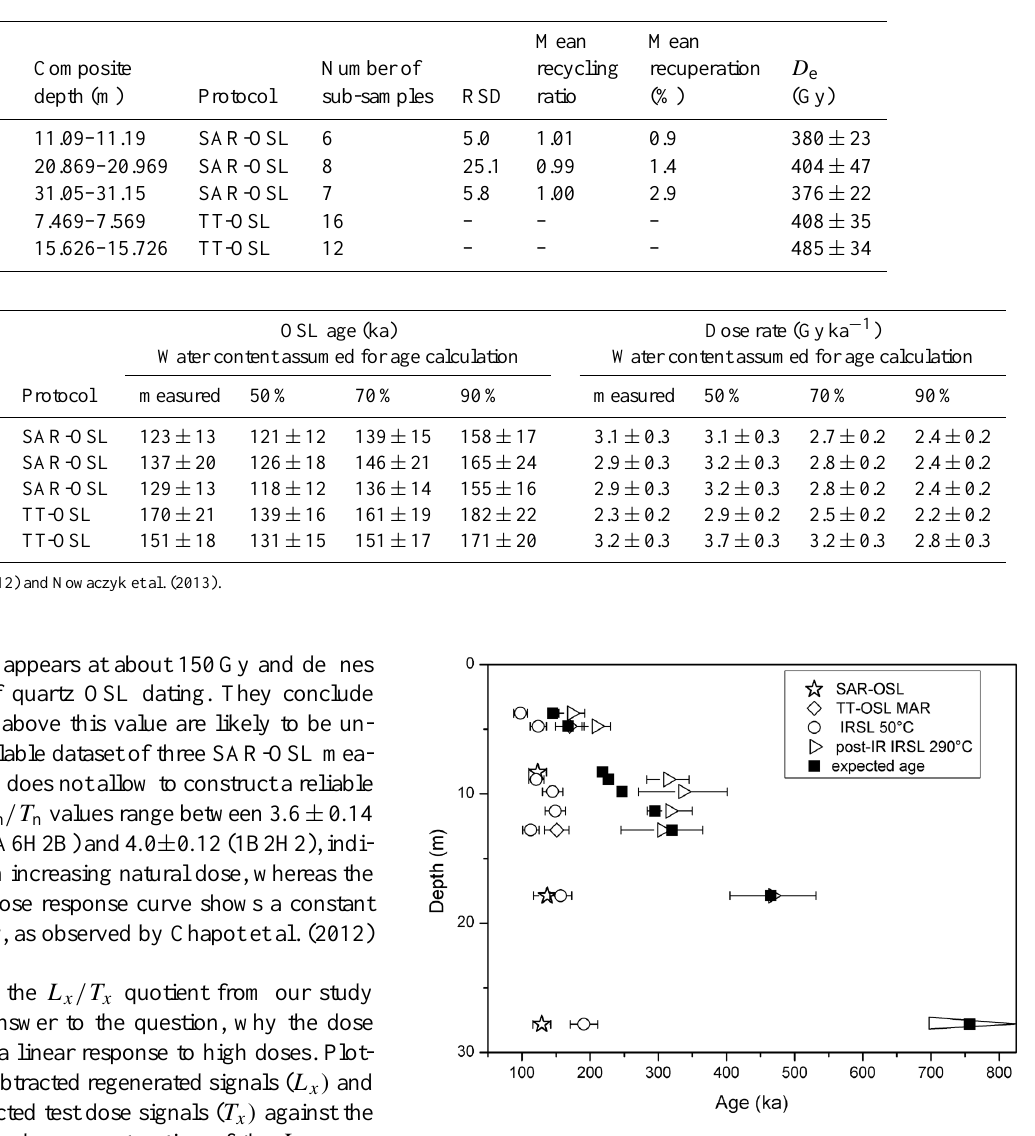
Fig. 6. Comparison of the expected ages from an independent age model (Melles et al., 2012; Nowaczyk et al., 2013) and lumines- cence ages determined with different luminescence dating proto- cols on fine grain quartz and on polymineral fine grain. The graph shows the luminescence ages which were calculated with the mea- sured water content. The extended triangle in the lower right corner correlates with the sample from the B/M boundary and is a symbol for the pIRIR 290 age of >